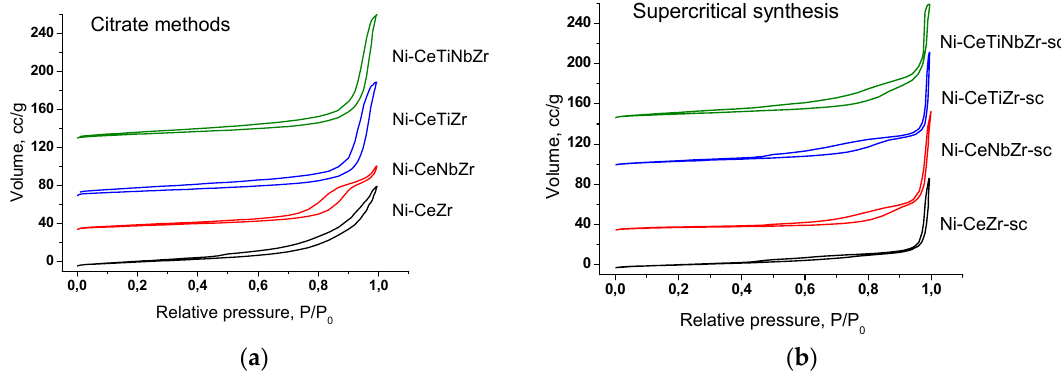
Figure 1. The nitrogen adsorption-desorption isotherms for catalysts based on mixed oxides prepared by citrate methods ( a ) and by supercritical synthesis ( b ).